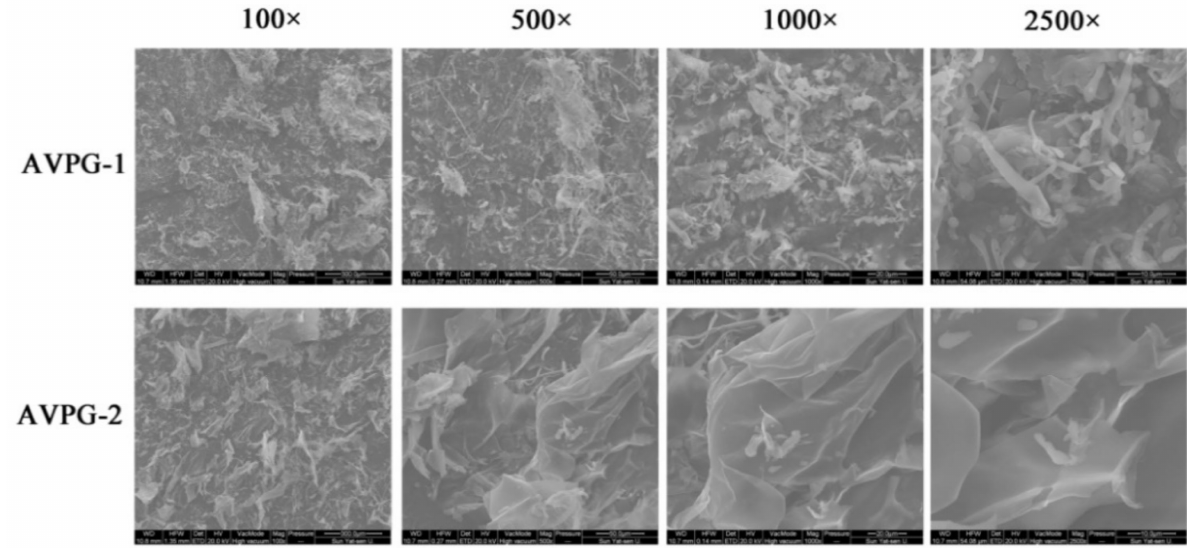
Figure 4. Scanningelectronmicroscope(SEM)imagesofAVPG − 1andAVPG − 2(at × 100, × 500, × 1000and ×